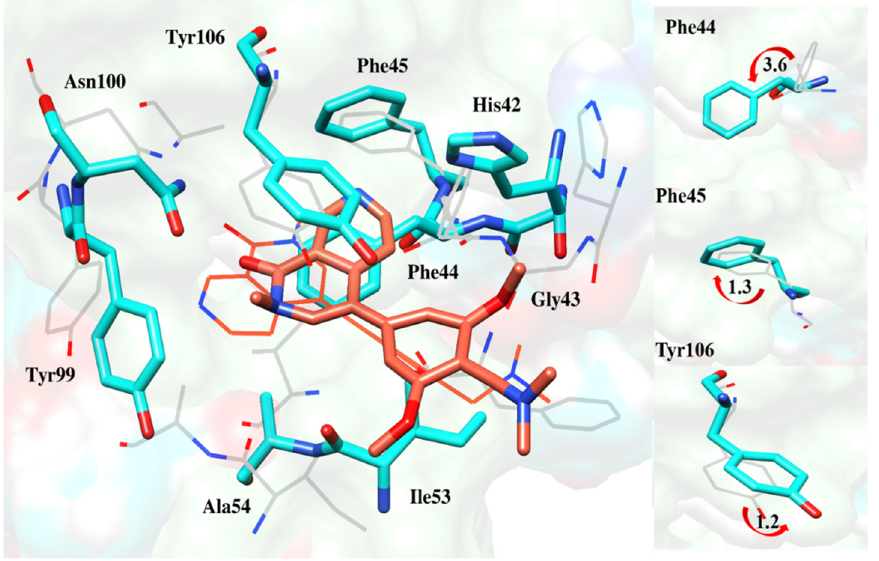
Figure 13. Deflection of Phe44, Phe45 and Tyr106 to accommodate the reference compound deeper inside the pocket [17].